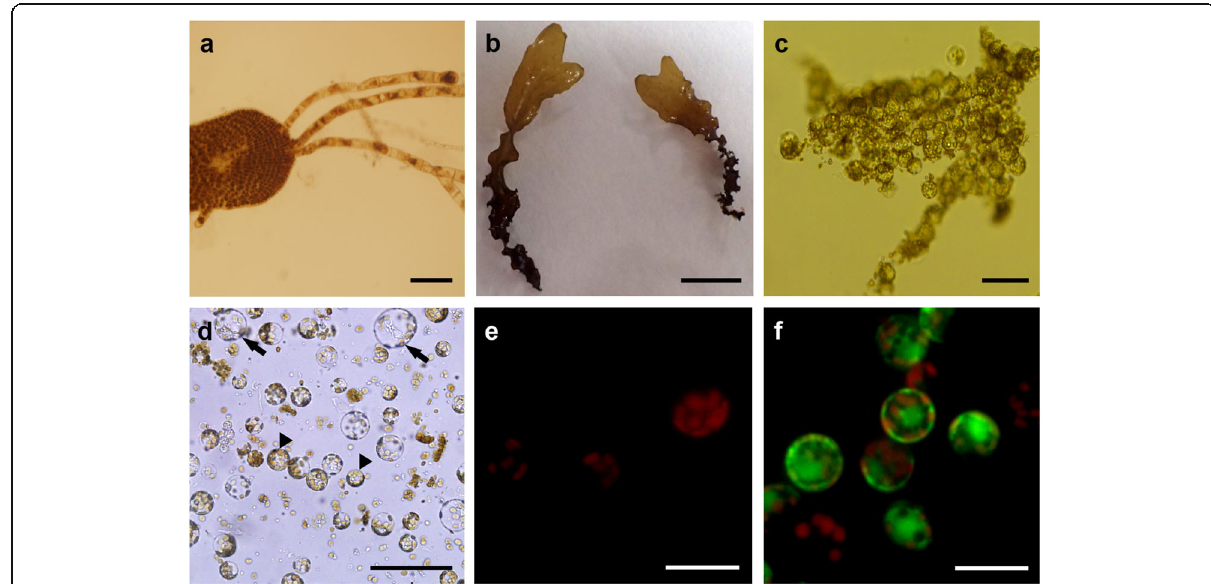
Fig. 1 Protoplast isolation from Dictyopteris pacifica . a A germline blade producing filaments in cultures without aeration (bar = 200 μ m). b Foliose thalli after 1 month in suspension culture (bar = 1 cm). c Spherical protoplasts from blade after 2 h of enzymatic digestion (bar = 100 μ m). d Freshly isolated protoplasts produced from the cortex (arrowheads) and medulla (arrows) (bar = 100 μ m). e True protoplasts with red chlorophyll autofluorescence under inverted fluorescence microscope showing no cell walls (bar = 10 μ m). f Protoplasts with green fluorescence stained with FDA showing their viability (bar = 10 μ m)